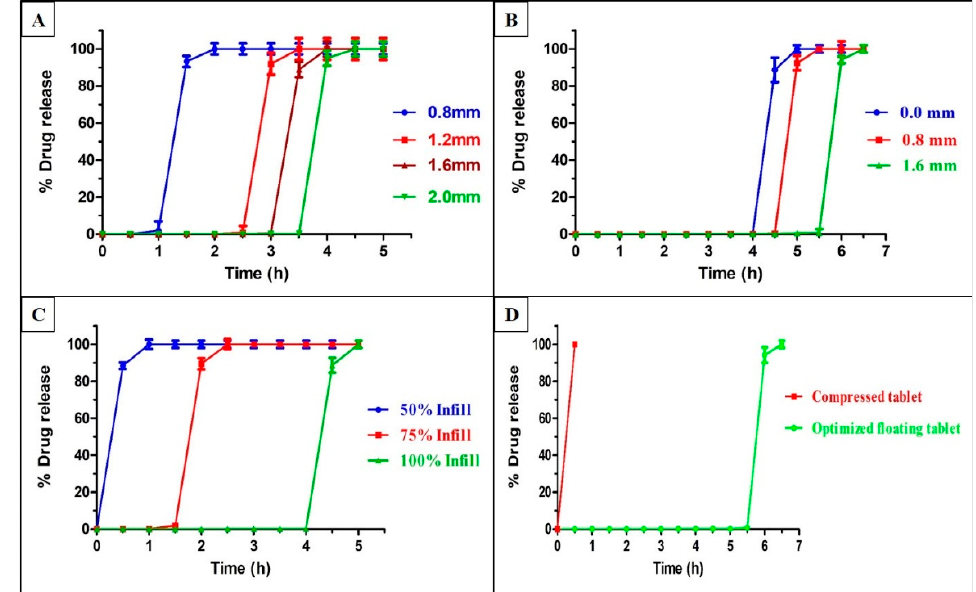
Figure 7. In vitro release profiles of the floating tablets with different shell thicknesses in 0.1 N HCl ( A ), different wall thicknesses ( B ), different fill densities ( C ), and optimized floating tablets and compressed tablets ( D ). Error bars represent mean ± S.D.